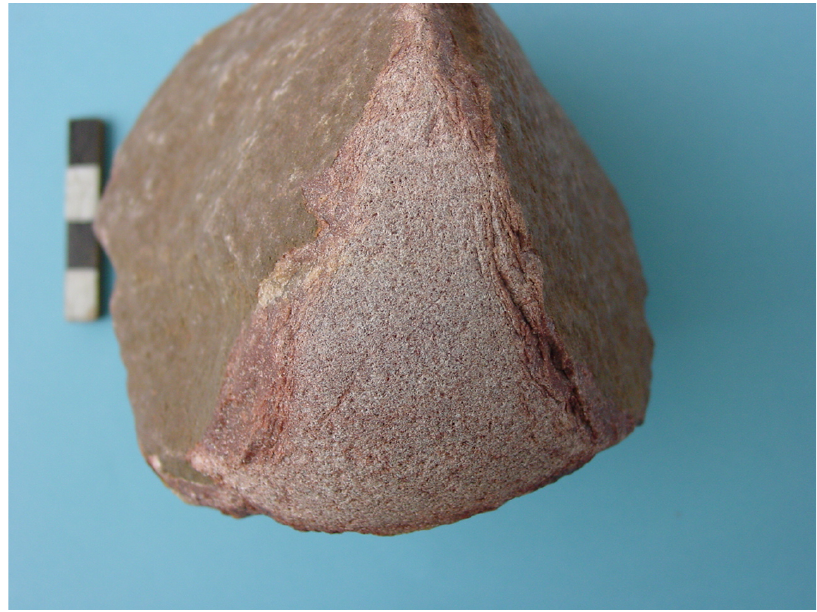
Figure 12. Hammer stone on hard quartzite cobble used for making